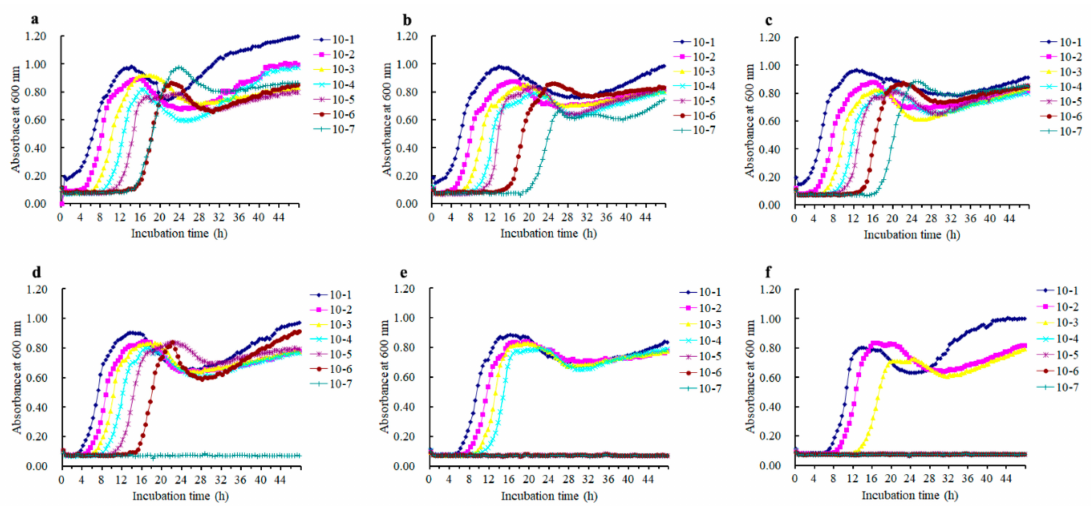
Figure 5. Regrowth of S. aureus mature biofilm after being treated with azalomycin F 5a . ( a ): S. aureus mature biofilm; ( b – f ): S. aureus mature biofilm treated with azalomycin F 5a at the concentration of 2.0, 4.0, 8.0, 16.0 and 32.0 µ g / mL, respectively.